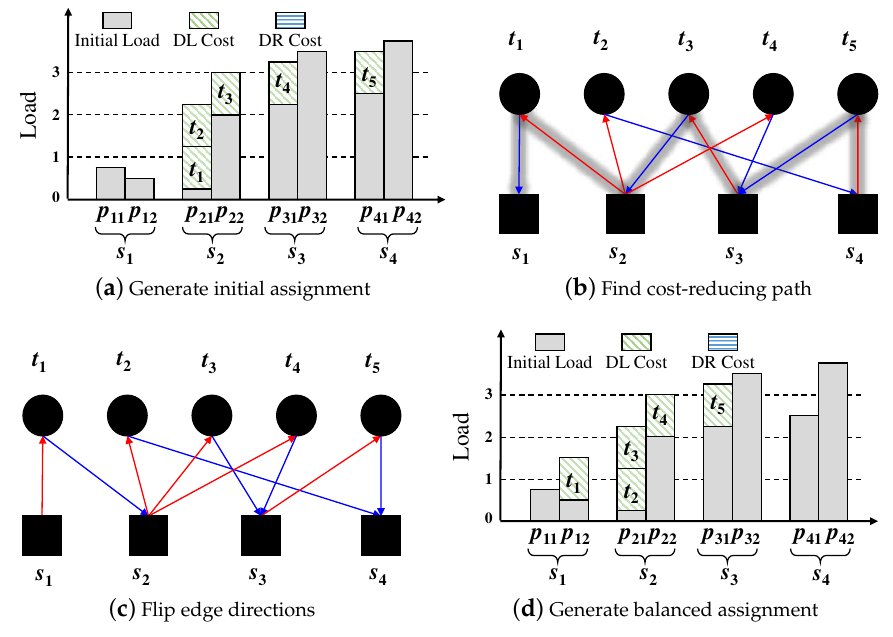
Figure 3. Key steps of Phase I. Algorithm 2: DynDLOff: Assign Data-Local Tasks (Phase